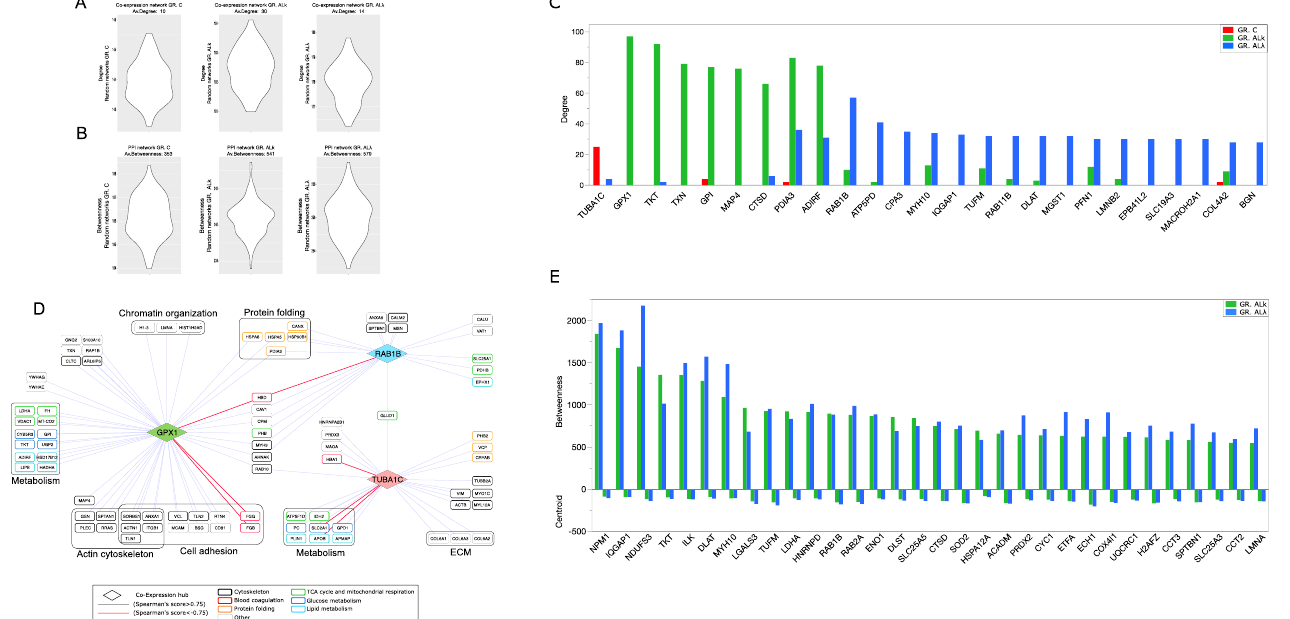
Figure 3. Protein-protein interaction (PPI) and co-expression network topology. ( A ) Validation of co- expression hubs. Violin plot of average degree values calculated from random co-expression networks ( n = 1000 per group); for each group of subjects, the average degree in the reference co-expression network is shown, whereas in ( B ), the validation of PPI hubs is shown. Violin plot of average betweenness values calculated from random PPI networks ( n = 1000 per group); for each group of subjects, the average betweenness in the reference PPI network is shown. ( C ) High-confidence differentially co- expressed proteins (co-expression hubs) selected by comparing the node degree from C, AL κ and AL λ co-expression network models (degree > 2 × network average degree). ( D ) Best-ranked co-expression hubs (TUBA1C in C, GPX1 AL κ and RAB1B in AL λ ) and their higher-confidence correlation partners (Spearman’s correlation score ≥| 0.85 | for GPX1 and RAB1B, ≥| 0.75 | for TUBA1C). ( E ) PPI hubs, selected by betweenness and centroid values, from both AL κ and AL λ PPI network